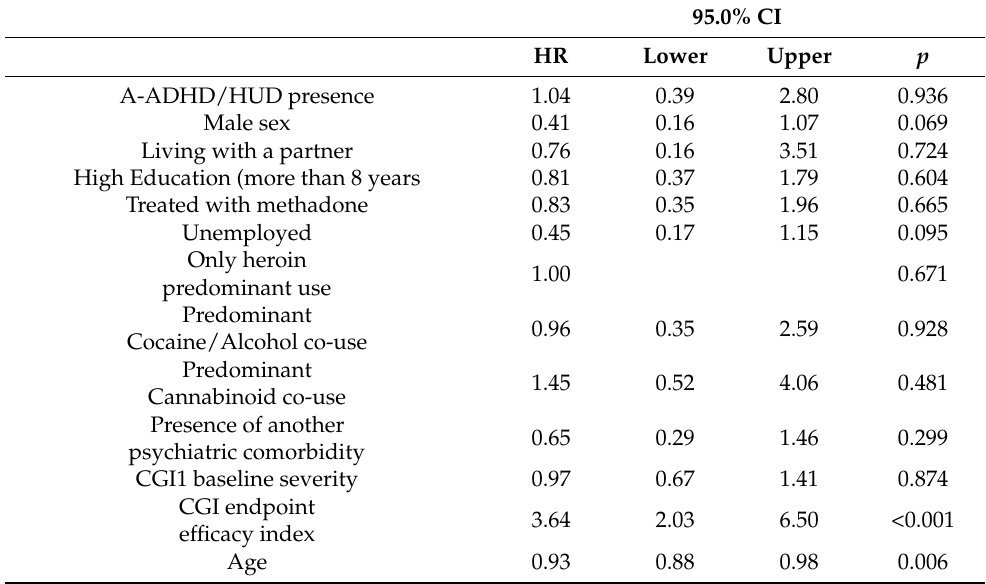
Figure 1. Survival in treatment of 130 HUD patients according to the co-presence of A-ADHD symptoms. Table 3. Predictors of negative